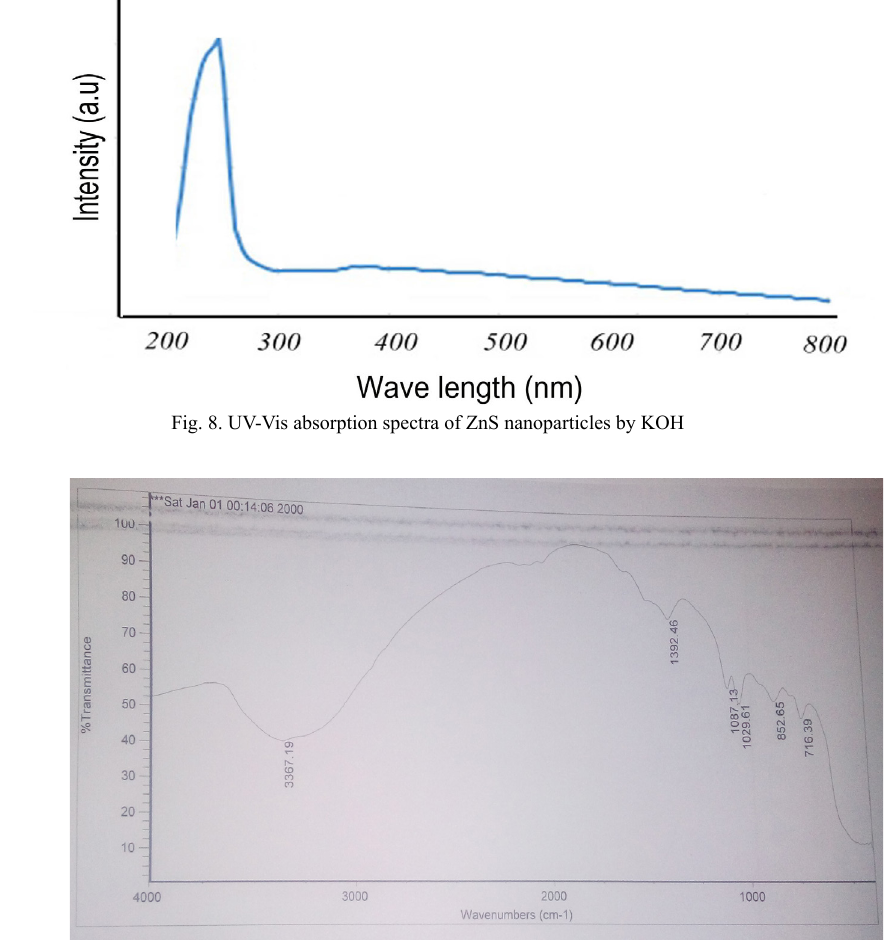
Fig. 9. FT-IR spectra of ZnS nanoparticles by